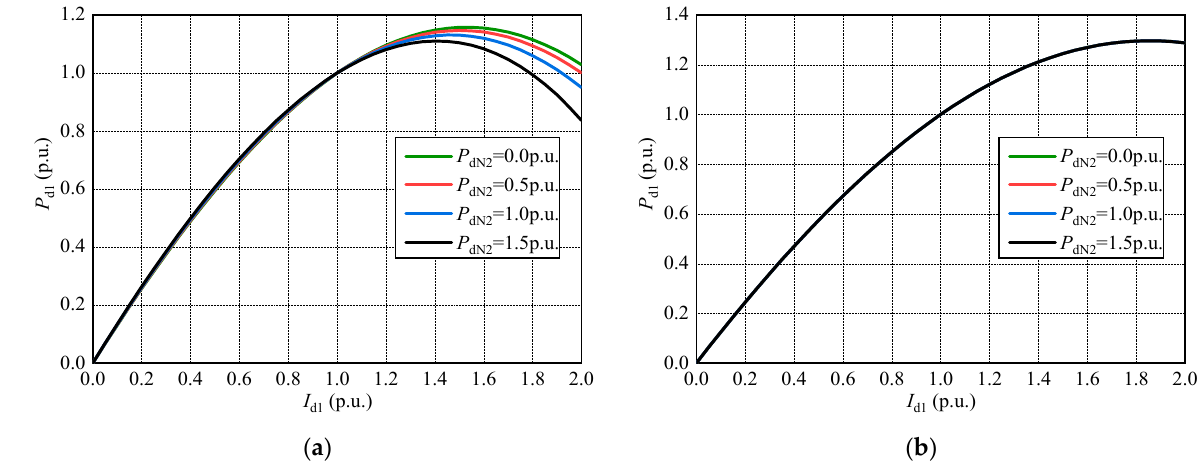
Figure 4. Maximum power curves of LCC-HVDC under different VSC-HVDC transmission power: ( a ) Constant reactive power control mode; ( b ) constant AC voltage control mode.